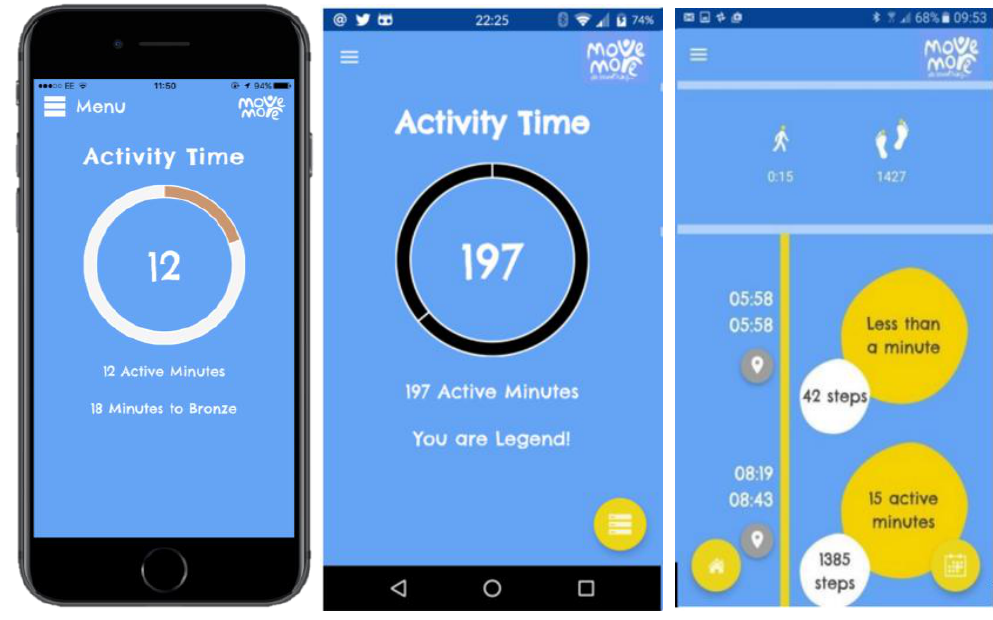
F igure 1. MoveMore app screenshots.